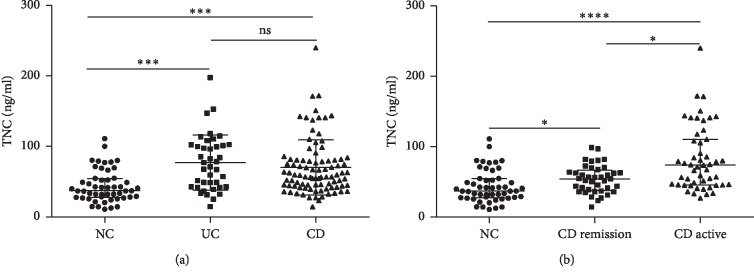
Serum TNC levels are increased in IBD. (a) Serum TNC levels in patients with UC (n = 40), CD (n = 91), and NCs (n = 52). (b) Serum TNC levels in NCs (n = 52), CD remission (n = 40), and CD active (n = 51). ∗P < 0.05, ∗∗∗P < 0.001, and ∗∗∗∗P < 0.0001. UC, ulcerative colitis; CD, Crohn's disease; NCs, normal controls.